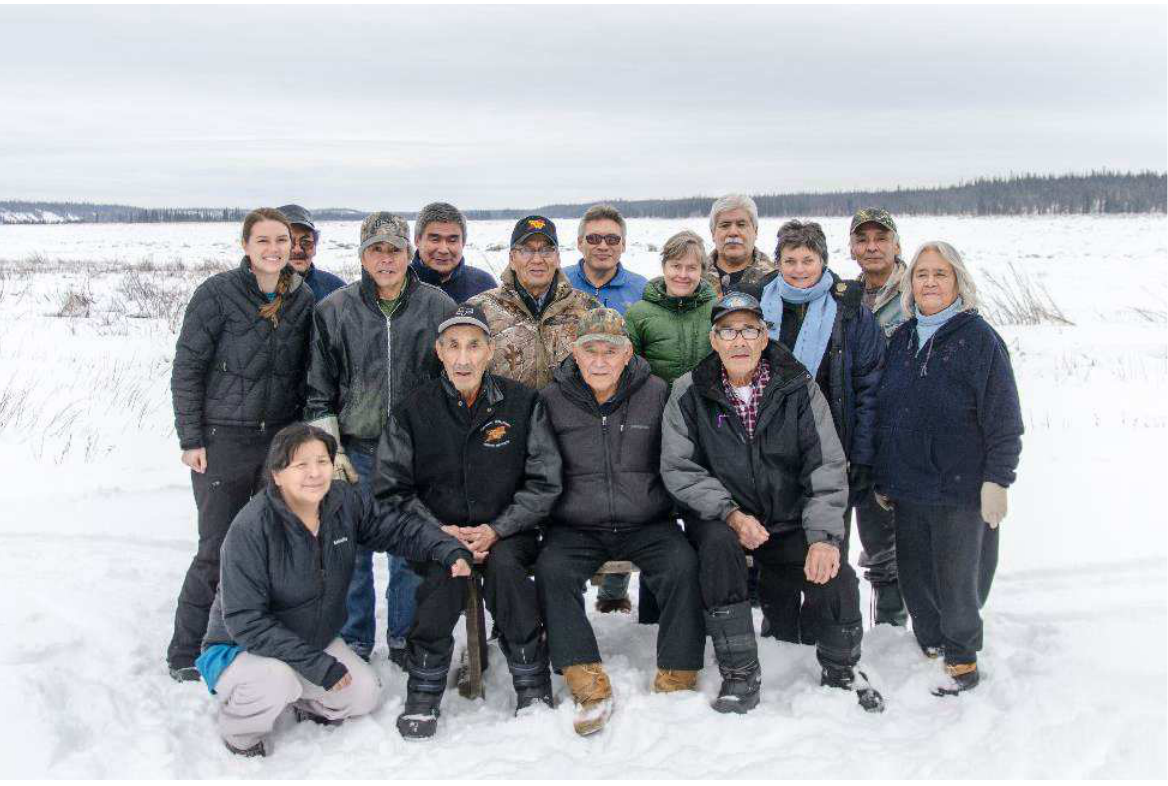
Figure A1.2. Advisory group members February 2015 at Deochah (Bennett Field), Northwest Territories: Back two rows – Jean Polfus, Gordon Yakeleya, Frederick Andrew,